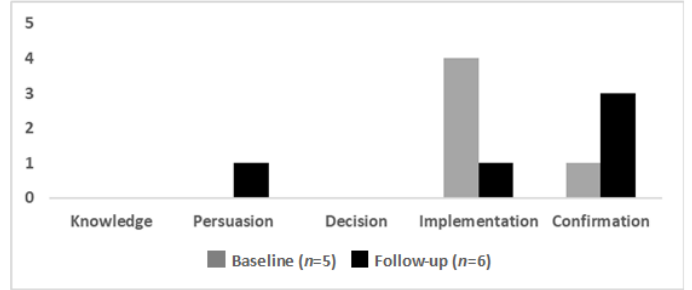
Figure 4. Stage of change at baseline and follow-up for participants to both surveys ( n = 4). One individual responded to the baseline survey only, while two responded to the follow-up survey only.